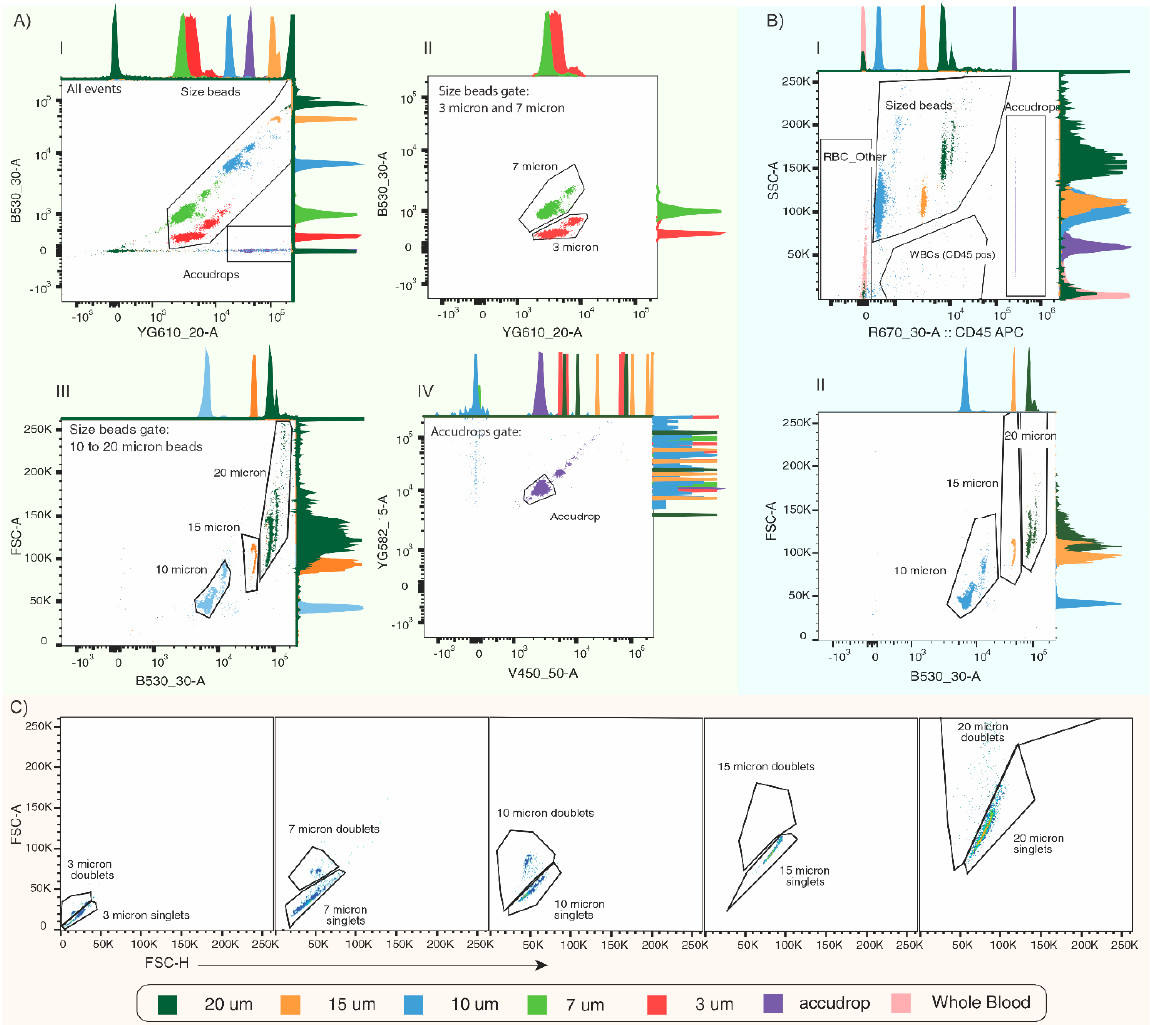
Figure 2. Gating strategy for the beads and cell samples used to validate the method. ( A ) gating strategy for bead only mix, ( I ) shows the initial separation of size beads from the counting beads (accudrops), ( II , III ) illustrates the gating method used to separate 3 μ m, 7 μ m, 10 μ m, 15 μ m, and 20 μ m beads from each other, ( IV ) shows the gate used to further identify the accudrop beads used for volume correction. ( B ) Gating strategy for blood and bead mixture ( I ) shows the initial separation of beads, cells and count beads, and ( II ) illustrates the separation of 10 μ m, 15 μ m, and 20 μ m beads from each other. ( C ) Doublet discrimination/cluster gating for 3 μ m, 7 μ m, 10 μ m, 15 μ m, and 20 μ m beads.